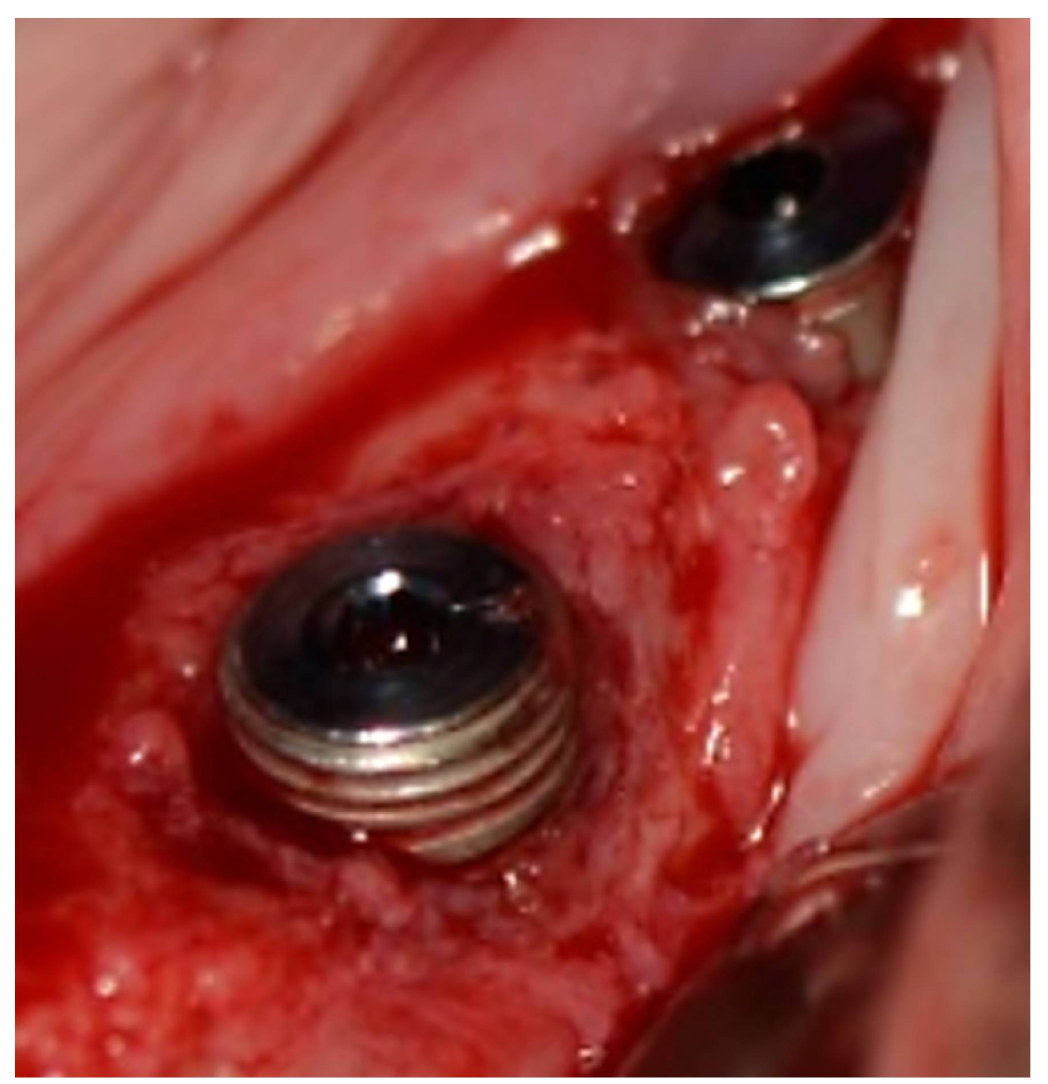
Figure 7. 3 mm buccal bone loss. Table 3. Buccal EMBL at stage-II surgery (mm). No. Implant No.